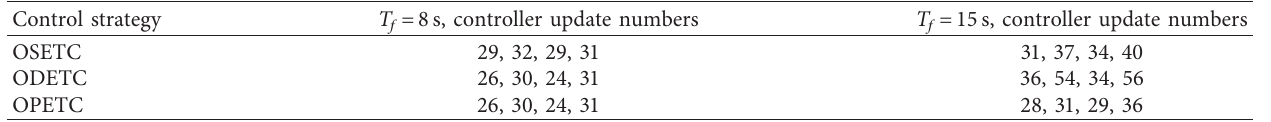
Table 2: Three control strategies for synchronization of